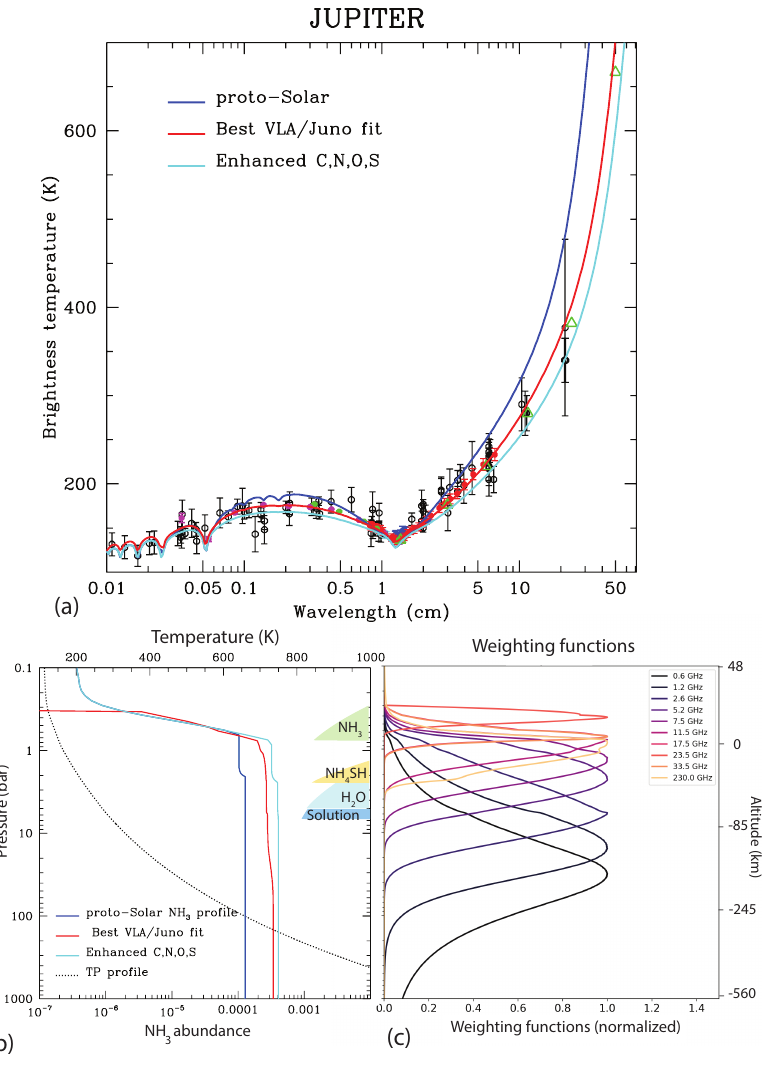
Figure 4. ( a ) Jupiter’s disk-averaged brightness temperature as a function of wavelength (Adapted from [13]). Red points: VLA data from 2013 to 2014 [13]; open black symbols: older data